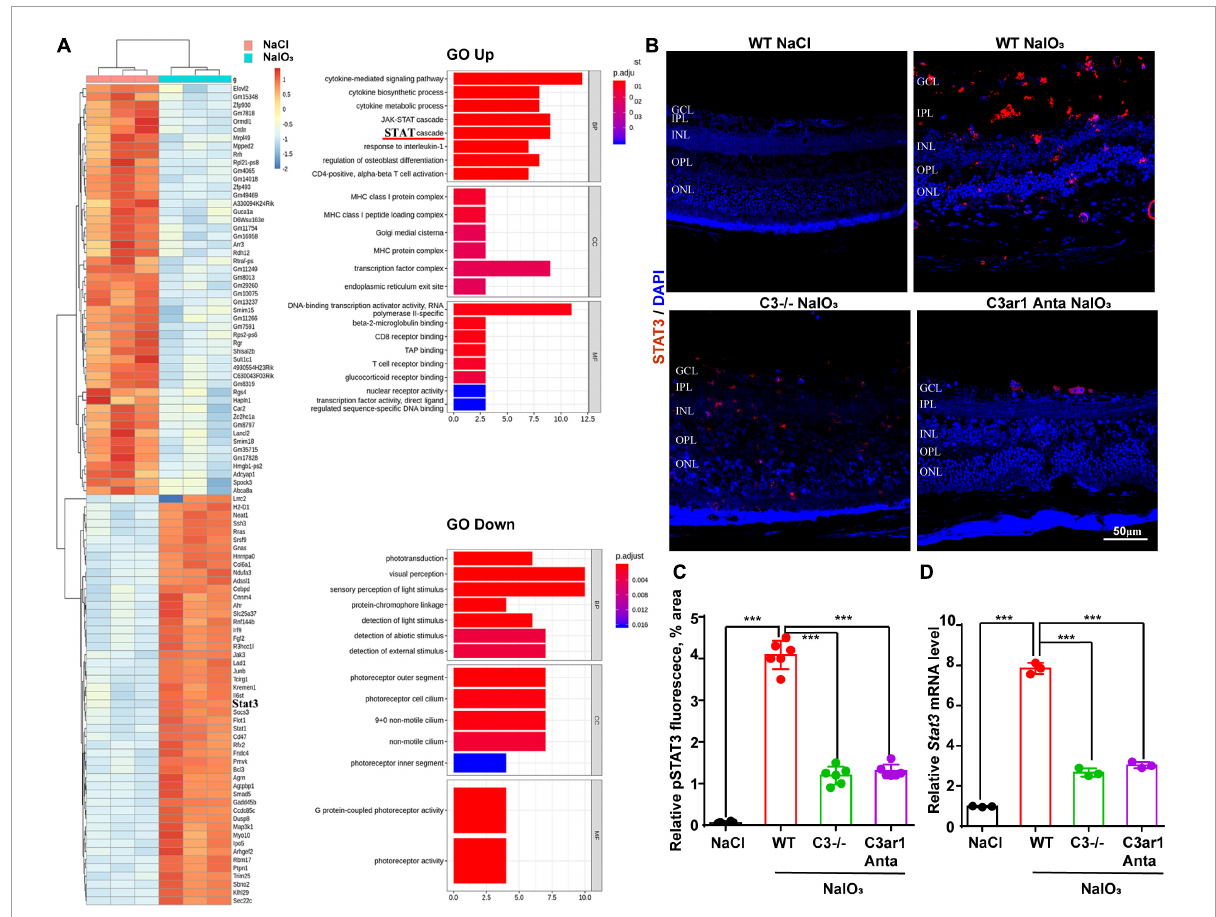
FIGURE7 RNA-seq analysis revealed C3/C3aR/STA3 signaling pathway activation in the NaIO 3 mouse model. (A) The top 100 DEGs in wild-type mice at 0 and 7 days after NaIO 3 induction. Gene Ontology analysis of the signaling pathways related to up- and downregulated genes. (B) Immunofluorescence staining of STAT3 in the retinas of saline control- and NaIO3-treated WT, C3-KO and C3ar1-inhibited mice. (C) Quantification of STAT3 in the retinas of saline control- and NaIO3-treated WT, C3-KO and C3ar1-inhibited mice. (D) Stat3 mRNA expression in retinas as determined by qRT–PCR. Each bar corresponds to the mean ± SD . *** p <